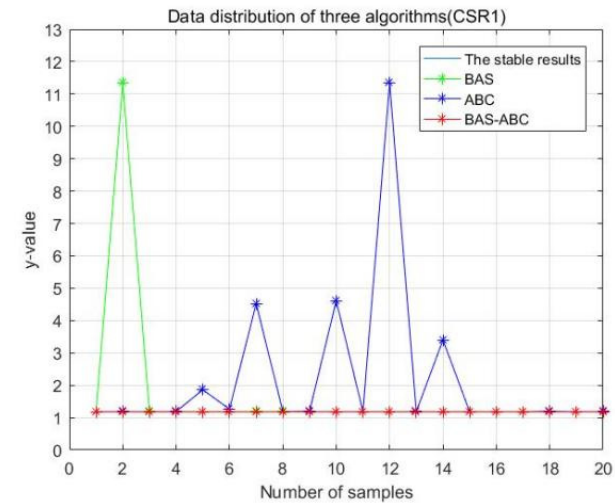
Figure 15. Data distribution-20 of three algorithms (CSR1).